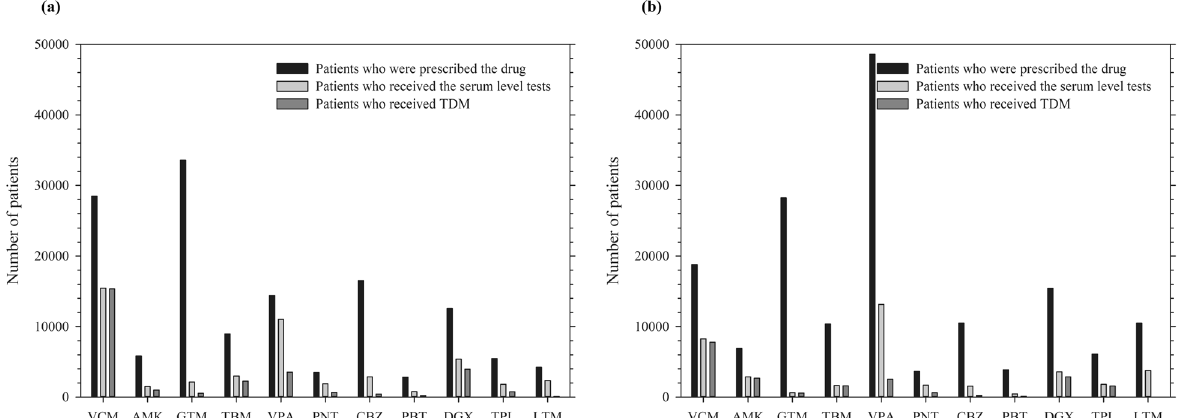
Figure 1. Patients who were prescribed drugs, serum level tests, or therapeutic drug monitoring. ( a ) Number of patients in Seoul National University Hospital and ( b ) Number of patients in Seoul National University Bundang Hospital. Abbreviation: VCM, vancomycin; AMK, amikacin; GTM, gentamicin; TBM, tobramycin; VPA, valproate; CBZ, carbamazepine; PNT, phenytoin; PBT, phenobarbital; DGX, digoxin; TPL, theophylline; LTM,